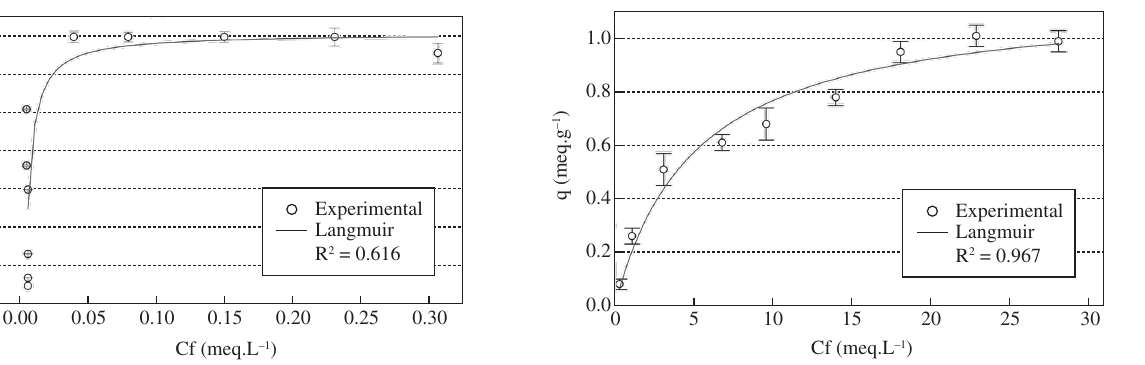
Figure 11. Equilibrium data (isotherm) of isopropilxanthate ions uptake, from aqueous solutions, by powdered modified zeolites. Contact time: 2 hours, CuZ: 10 g.L –1 , temperature: 25 °C, pH: 8.0. Experimental error: ± 0,004 meq.g –1 .